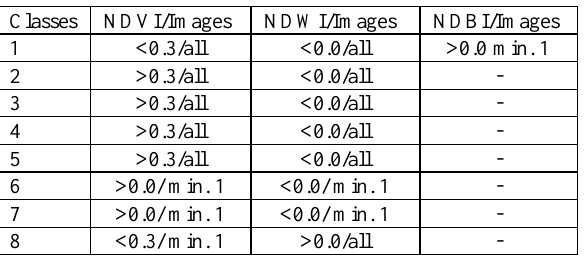
Table 3 NDVI, NDBI and NDWI threshold values to consider a pixel for a given class. “Images” indicates in how many of the used images the conditions need to be met, from the total of 3 images per year per study area.